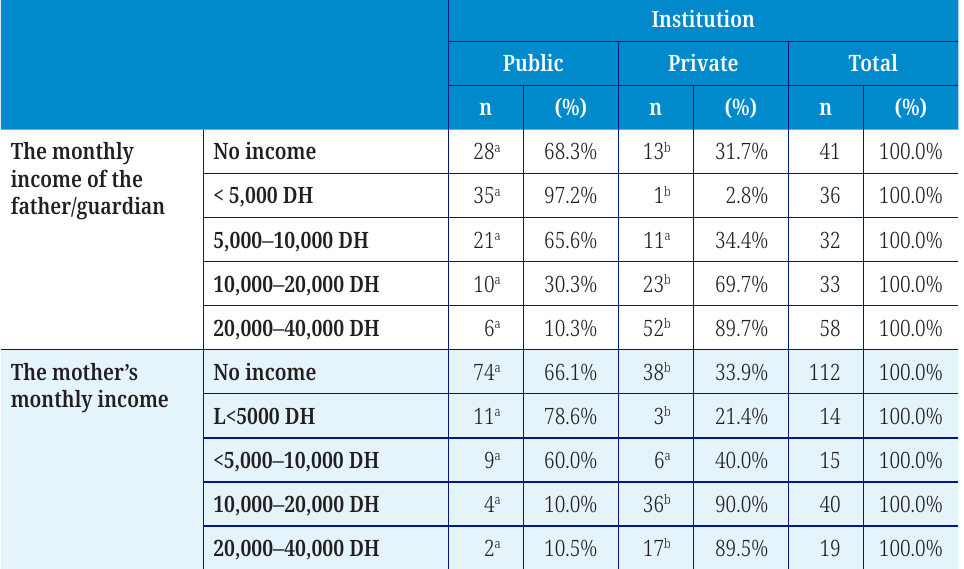
Table 7. Economic status of parents of public/private university students